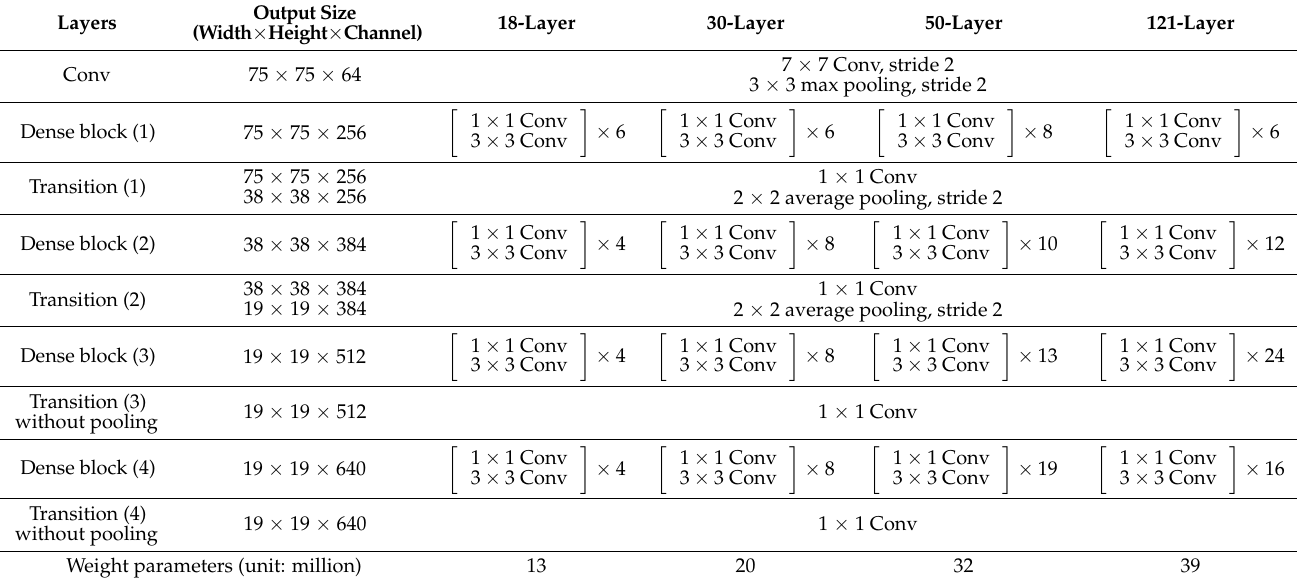
Table 5. Model specification of DenseNet based on SSD architecture.